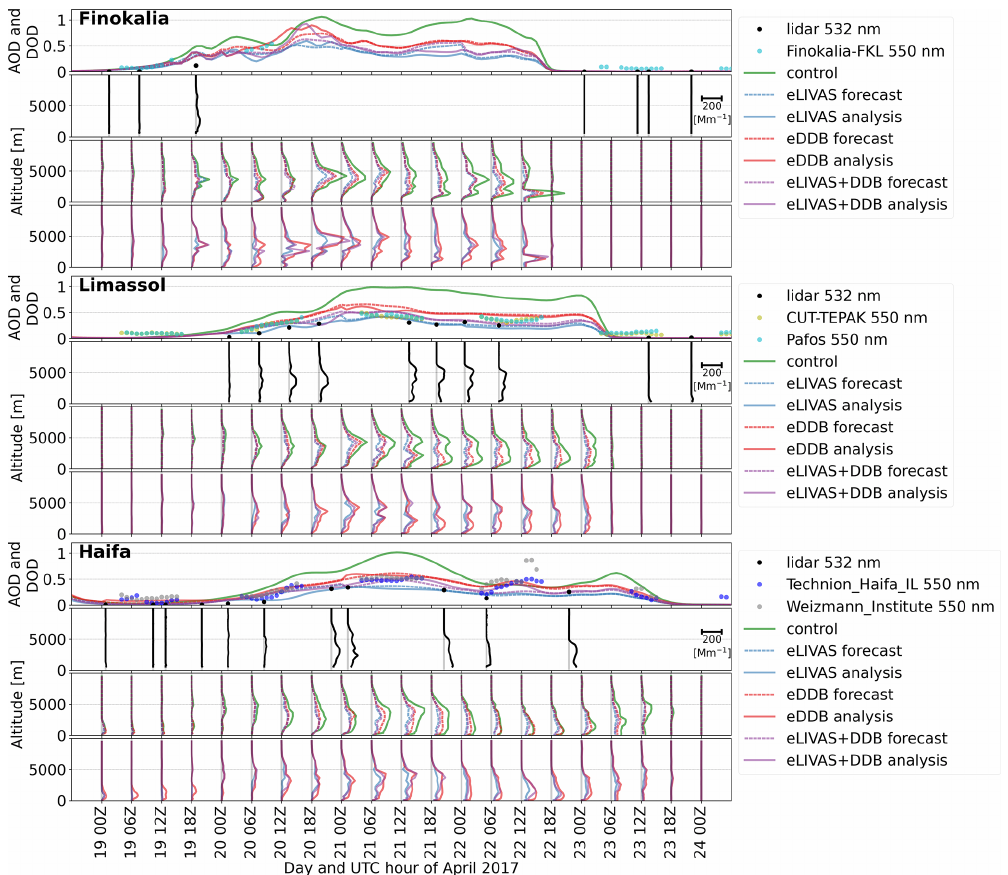
Figure 7. Simulated and measured dust extinction coefficient during the CyCARE and Pre-TECT campaigns by PollyNET lidars. The figure contains three groups (for the three measurement sites) with four panels each. The first panel of each group shows the DOD evolution estimated from the lidar measurements (black dots, equal to the vertical integration of the dust extinction coefficient profiles), the AOD without dust filtering for the AERONET station (coloured dots), the DOD of the control experiment (green line), the DOD from the forecasts (dashed lines), and analyses (continuous lines) for the three selected assimilation experiments. The second row of each group shows the vertical profiles of the measured dust extinction coefficient. The third row of each group shows the dust extinction coefficient from the control run (in green) and the forecasts (dashed lines). The fourth row of each group shows the dust extinction coefficient from the analyses. The scale for all the dust extinction coefficient profiles is shown on the right-hand side of the second panel in each